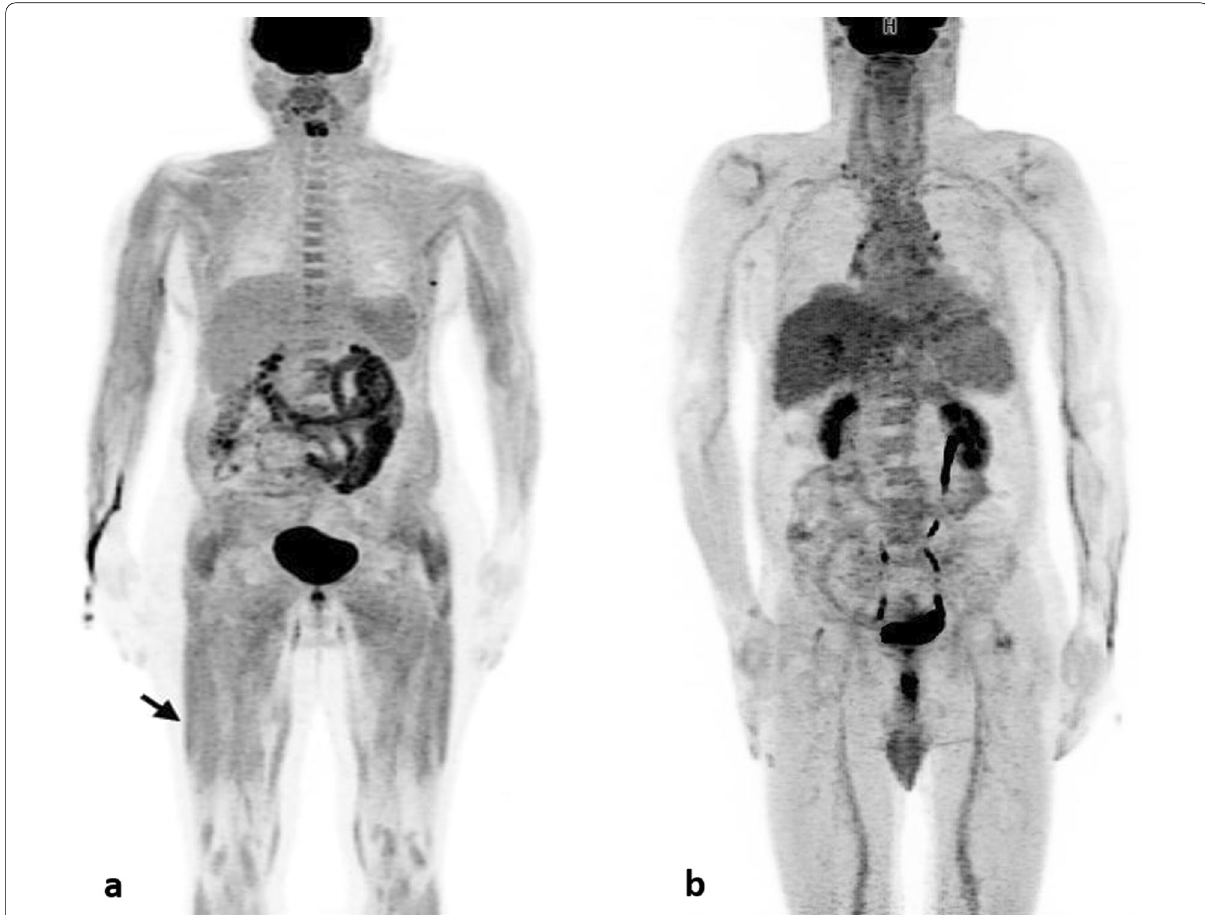
Fig. 4 MIP images of patient with Inflammatory Myositis (left panel) and that of a control patient with Amyotrophic Lateral Sclerosis (right